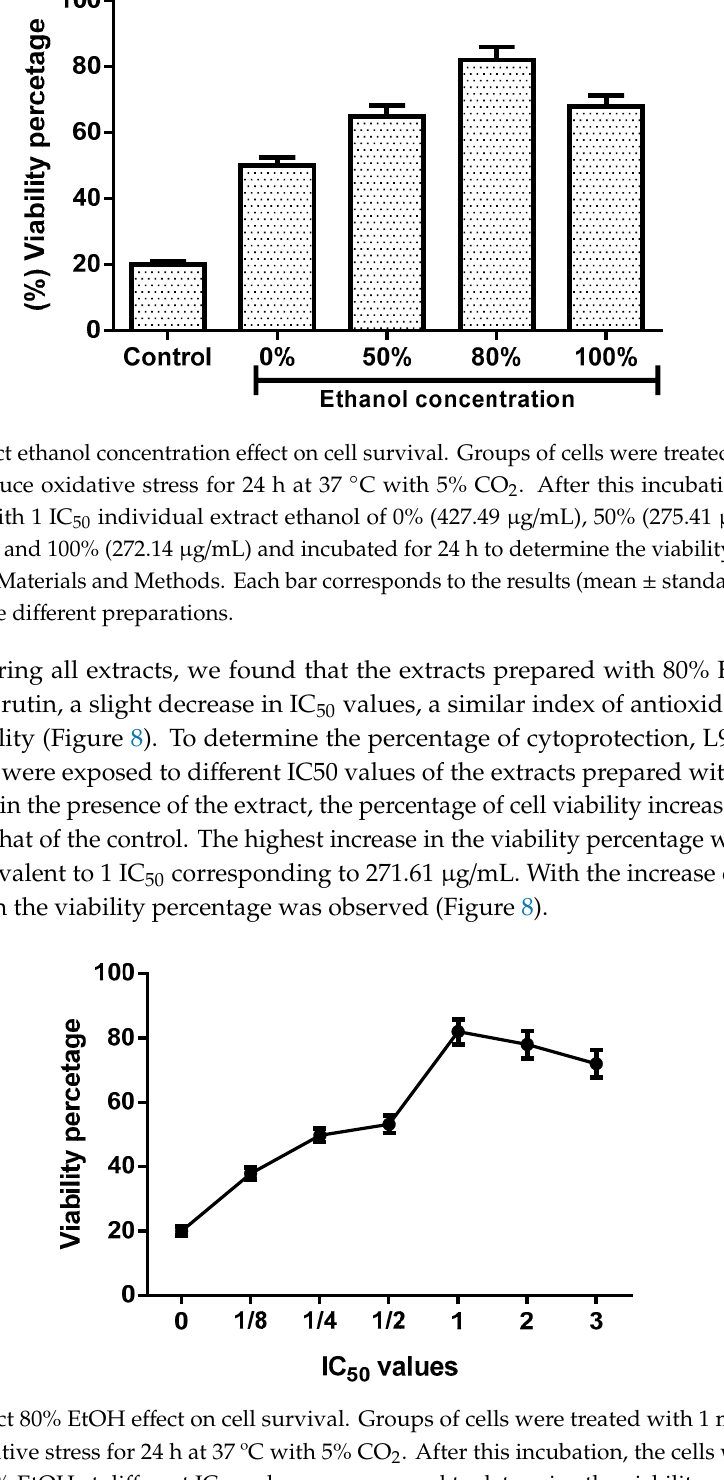
corresponds to the results (mean ± standard deviation (SD)) from three different preparations.